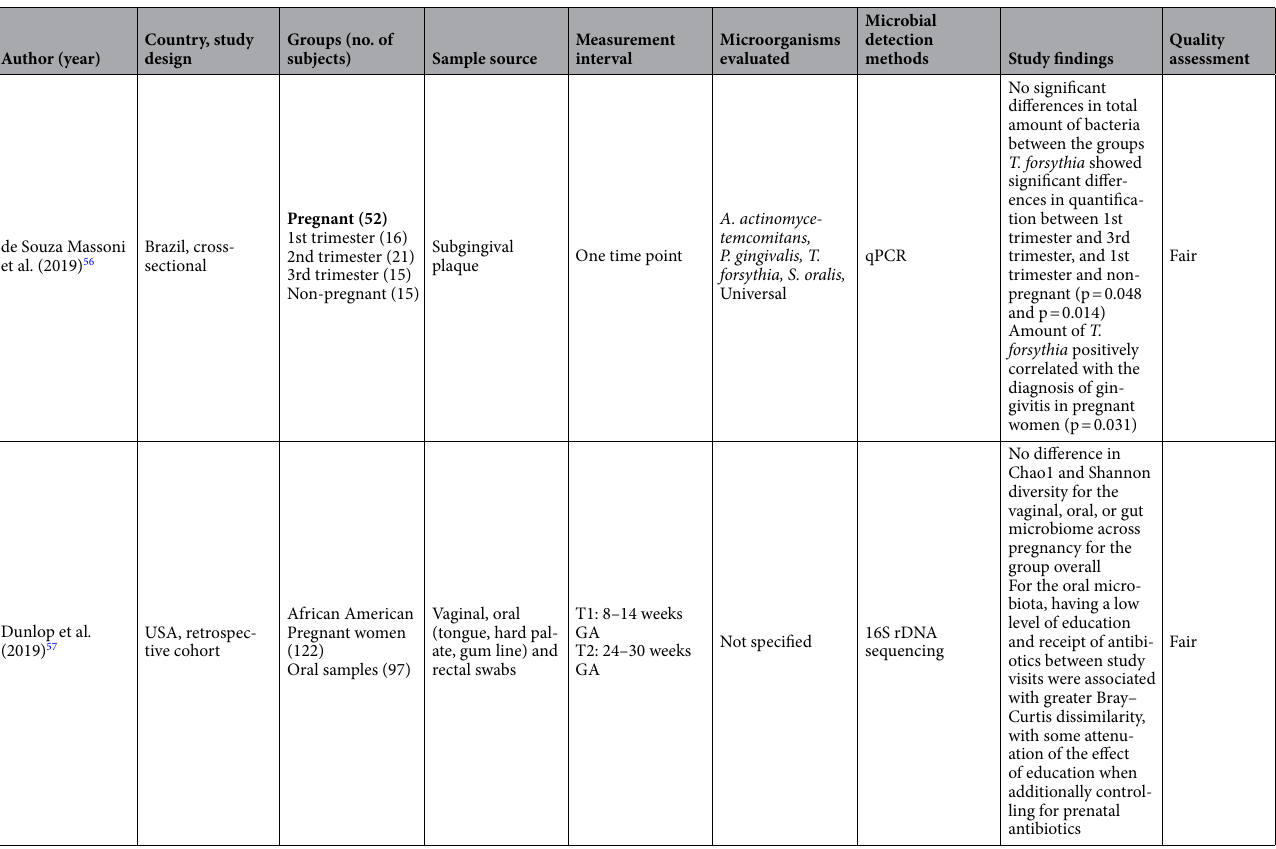
Table 2. Oral microbial differences between pregnancy